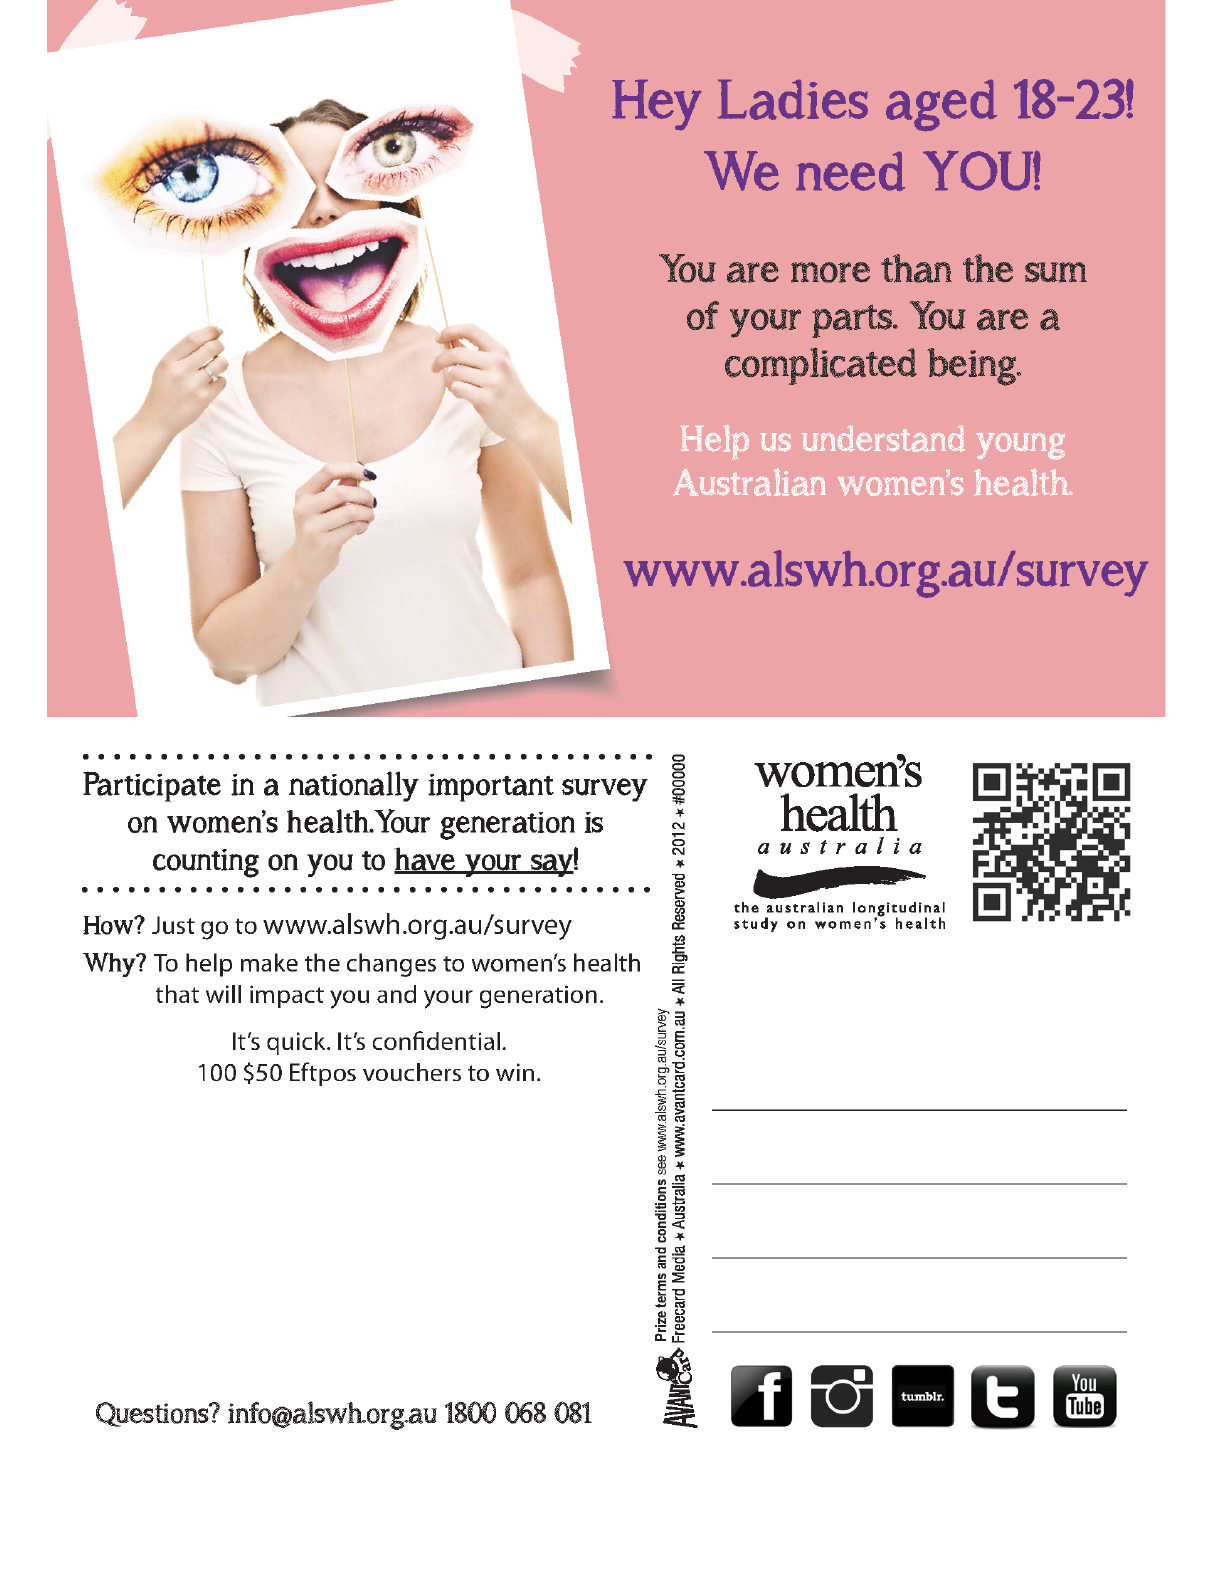
Figure 1. A postcard created as part of the ALSWH promotion, distributed across 1439 venues, at events, and through